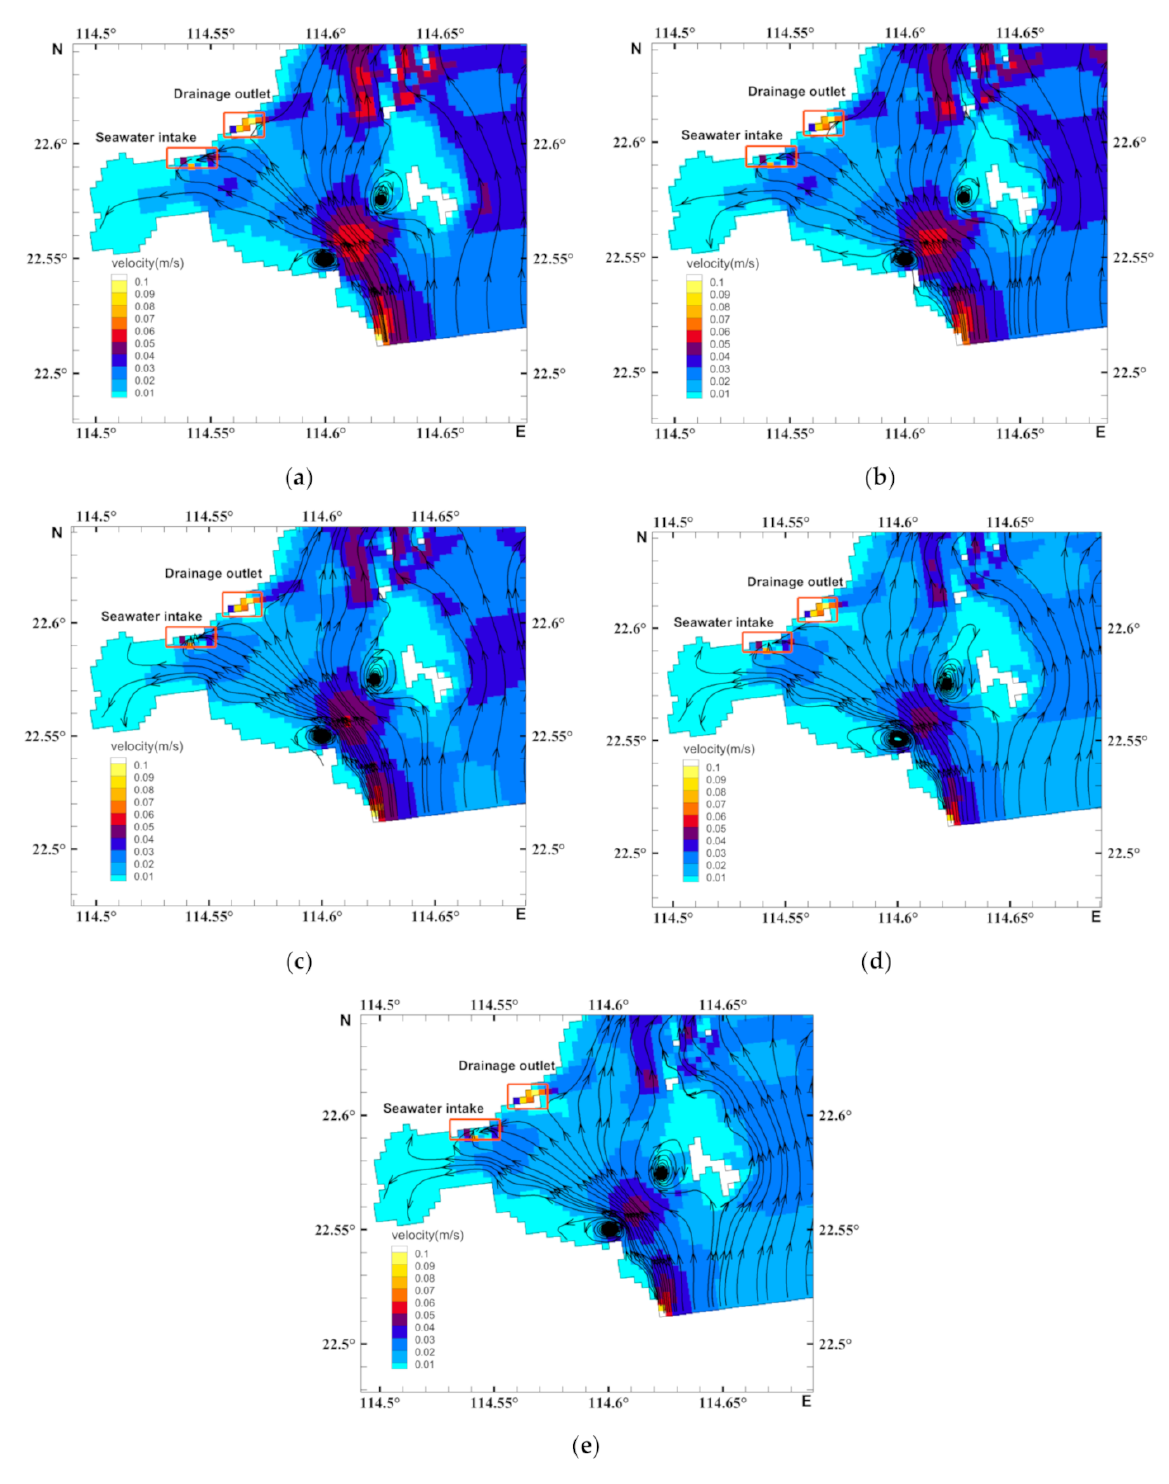
Figure 7. Maximal residual velocity field near water intake for various cases: ( a ) 12 h nighttime; ( b ) 13 h nighttime; ( c ) 14 h nighttime; ( d ) 15 h nighttime; and ( e ) 16 h